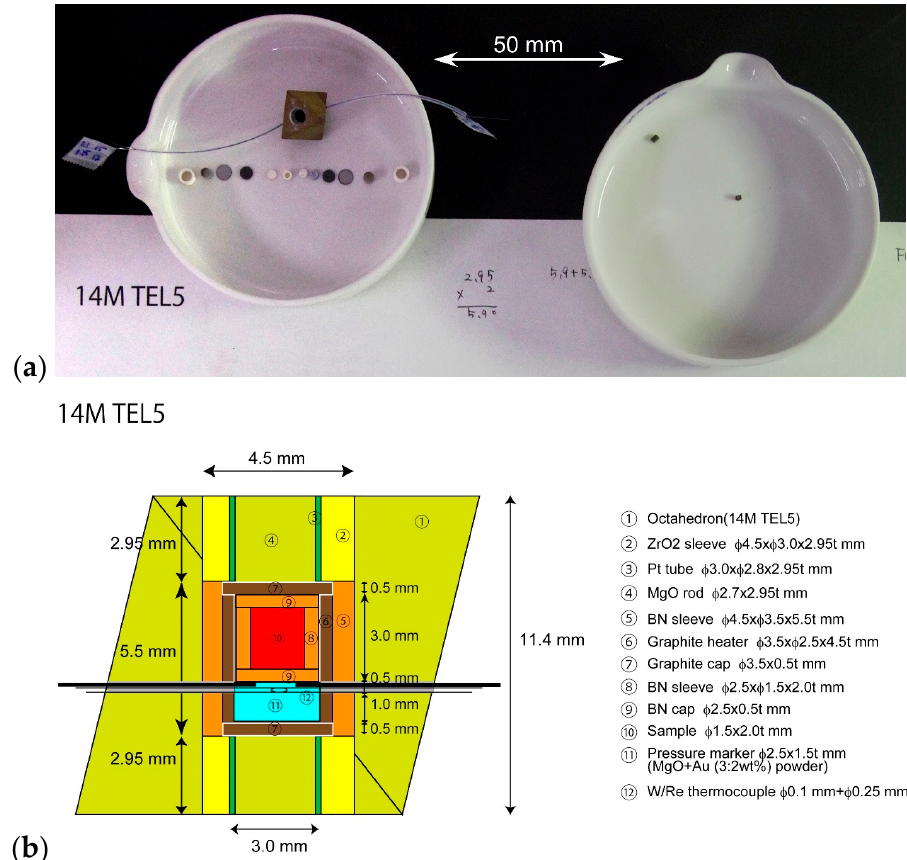
Figure 3. Typical radiographies of the pressure cell for sample alignment. The horizontal and vertical instrument axes show up and right in the figure. Translation of the entire apparatus with respect to the beam allows for different fields of view. The looped thermo ‐ couple is a feature that can be well recognized in the left and central picture. To the right, beam size has been reduced to focus on a particular volume only, here the pressure marker.